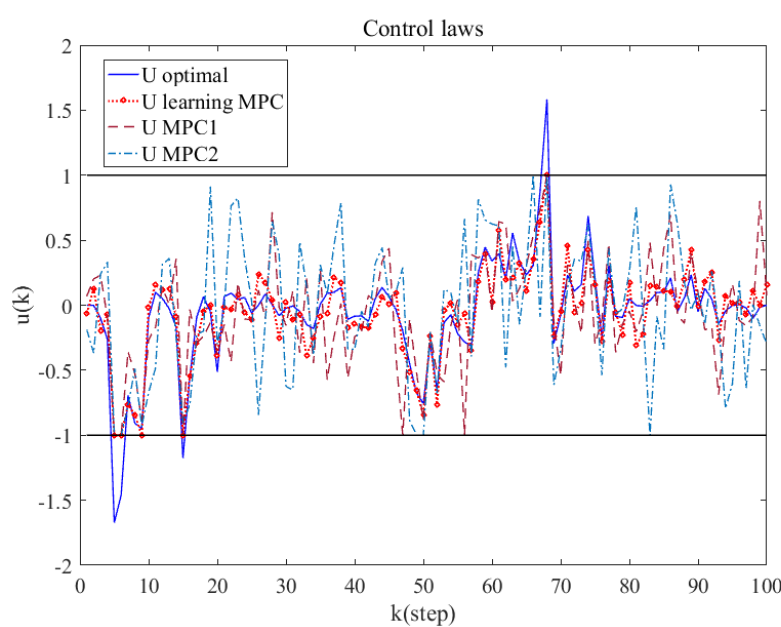
Figure 8. Comparison of various MPC control